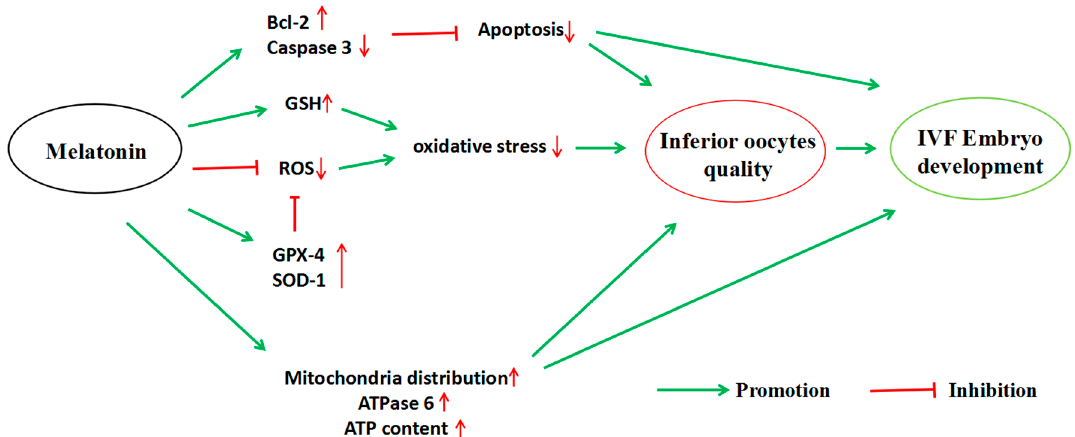
Figure 8. The action pathway connecting the beneficial effect of melatonin on bovine inferior oocytes and their subsequent IVF embryo development.